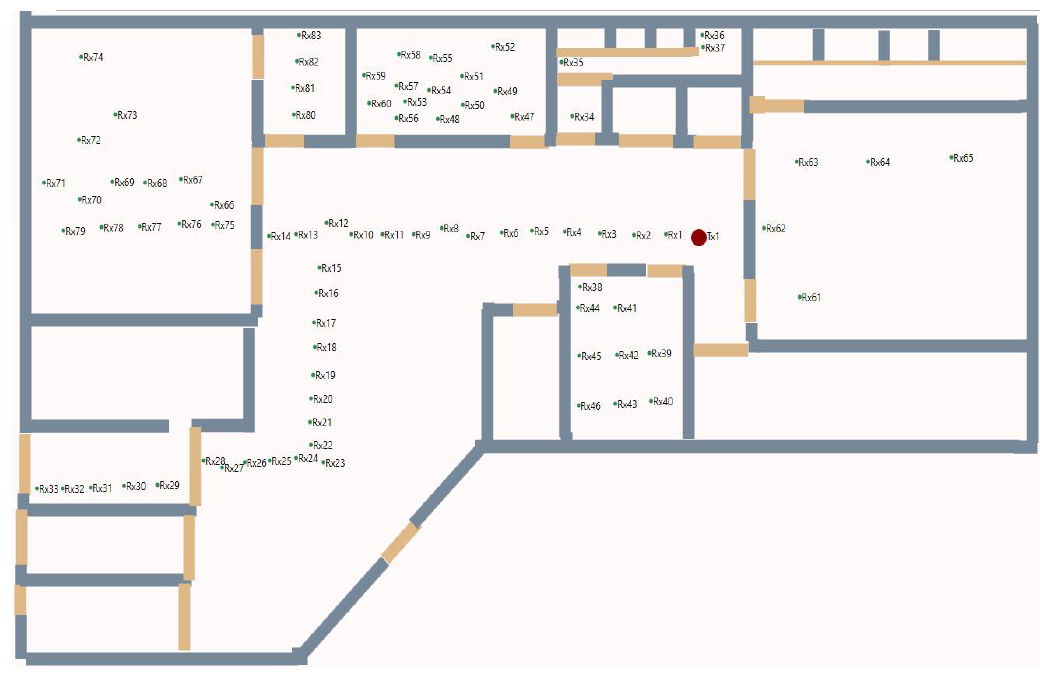
Figure 3. 2-D layout design of WCC P15a environment.